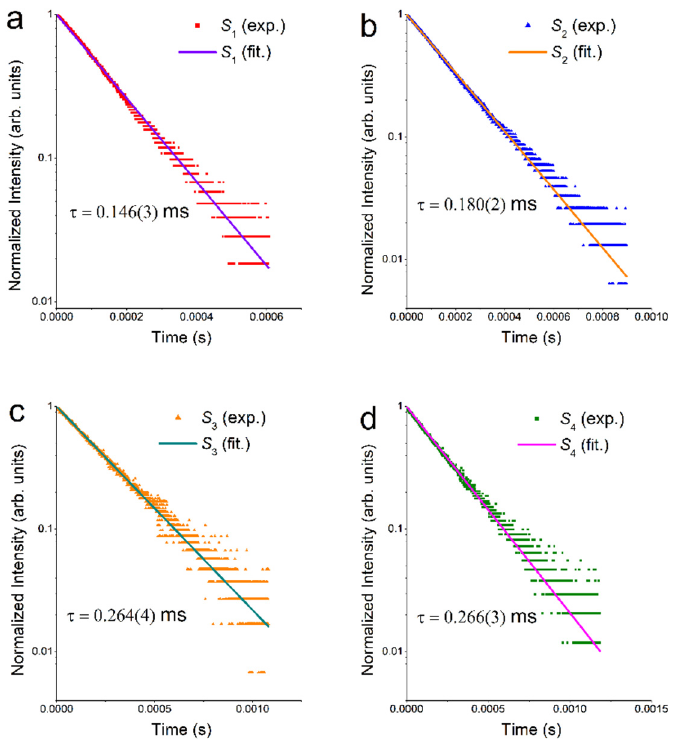
Figure 4. Decay curves being obtained experimentally for 4 I 13/2 → 4 I 15/2 electron transition in Er:YAG ( S 1 , S 2 ) (( a , b ), respectively) and Er:YSAG ( S 3 , S 4 ) (( c , d ), respectively) ceramics at 300 K.